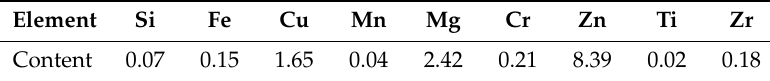
Table 1. Chemical compositions of as-cast samples (wt